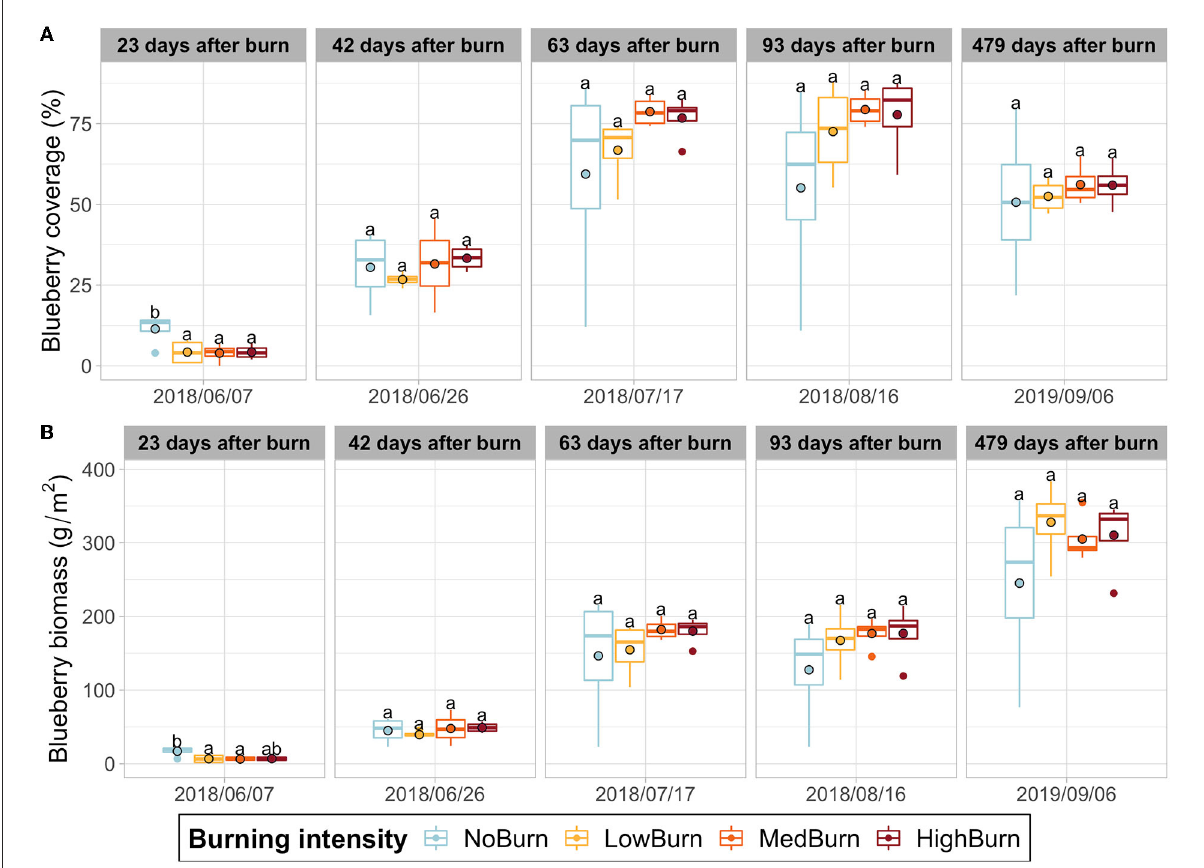
FIGURE1 Blueberry coverage and biomass production over time. Mean value is indicated with a black-circled dot. (A) Wild blueberry coverage. (B) Wild blueberry biomass production computed using the relation found by Lévesque et al. (2018). Significant difference in each sampling date is indicated by letters according to post hoc Tukey